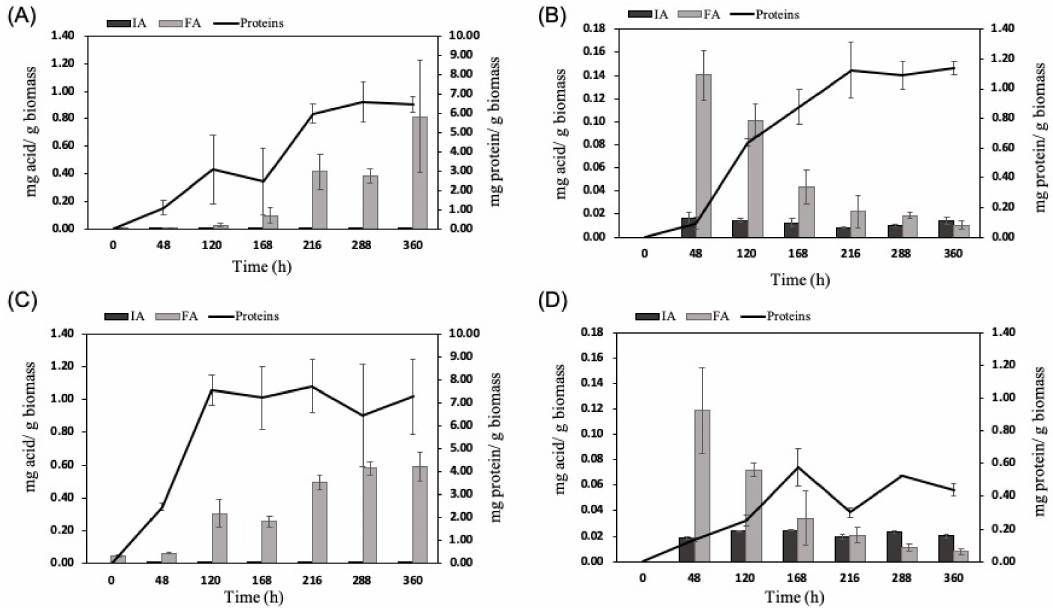
Figure 1. Fermentation kinetics on lignocellulosic biomasses: itaconic acid (IA) and fumaric acid (FA) yields and protein production (fungal growth) from wheat bran ( A , C ) and corn cobs ( B , D ) by A. terreus ( A and B , respectively) and by A. oryzae ( C and D ,